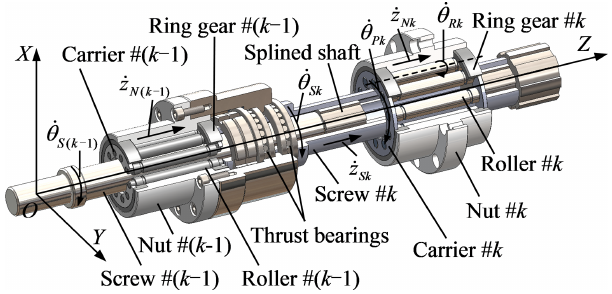
Figure 1. Structure and motion analysis of the multi-stage planetary roller screw mechanism (multi-stage